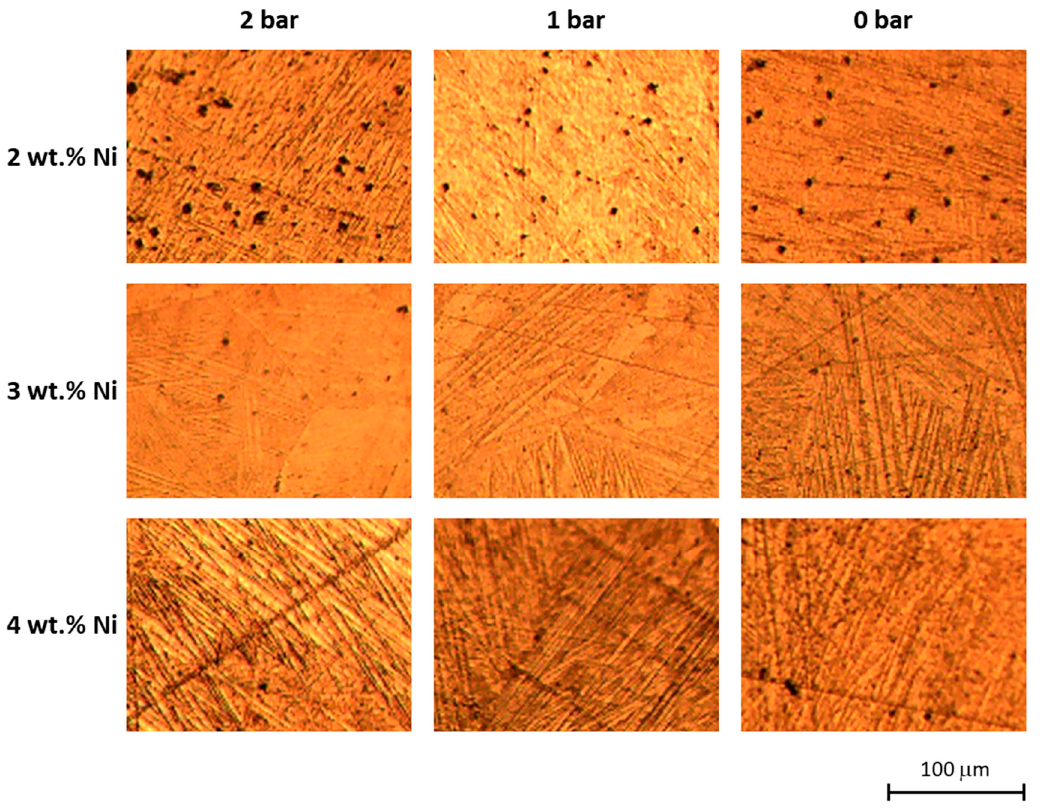
Figure 5. Microstructure of the alloys fabricated at the indicated conditions of relative pressure and nominal Ni content observed under optical microscopy. The scale bar is common to all micrographs.